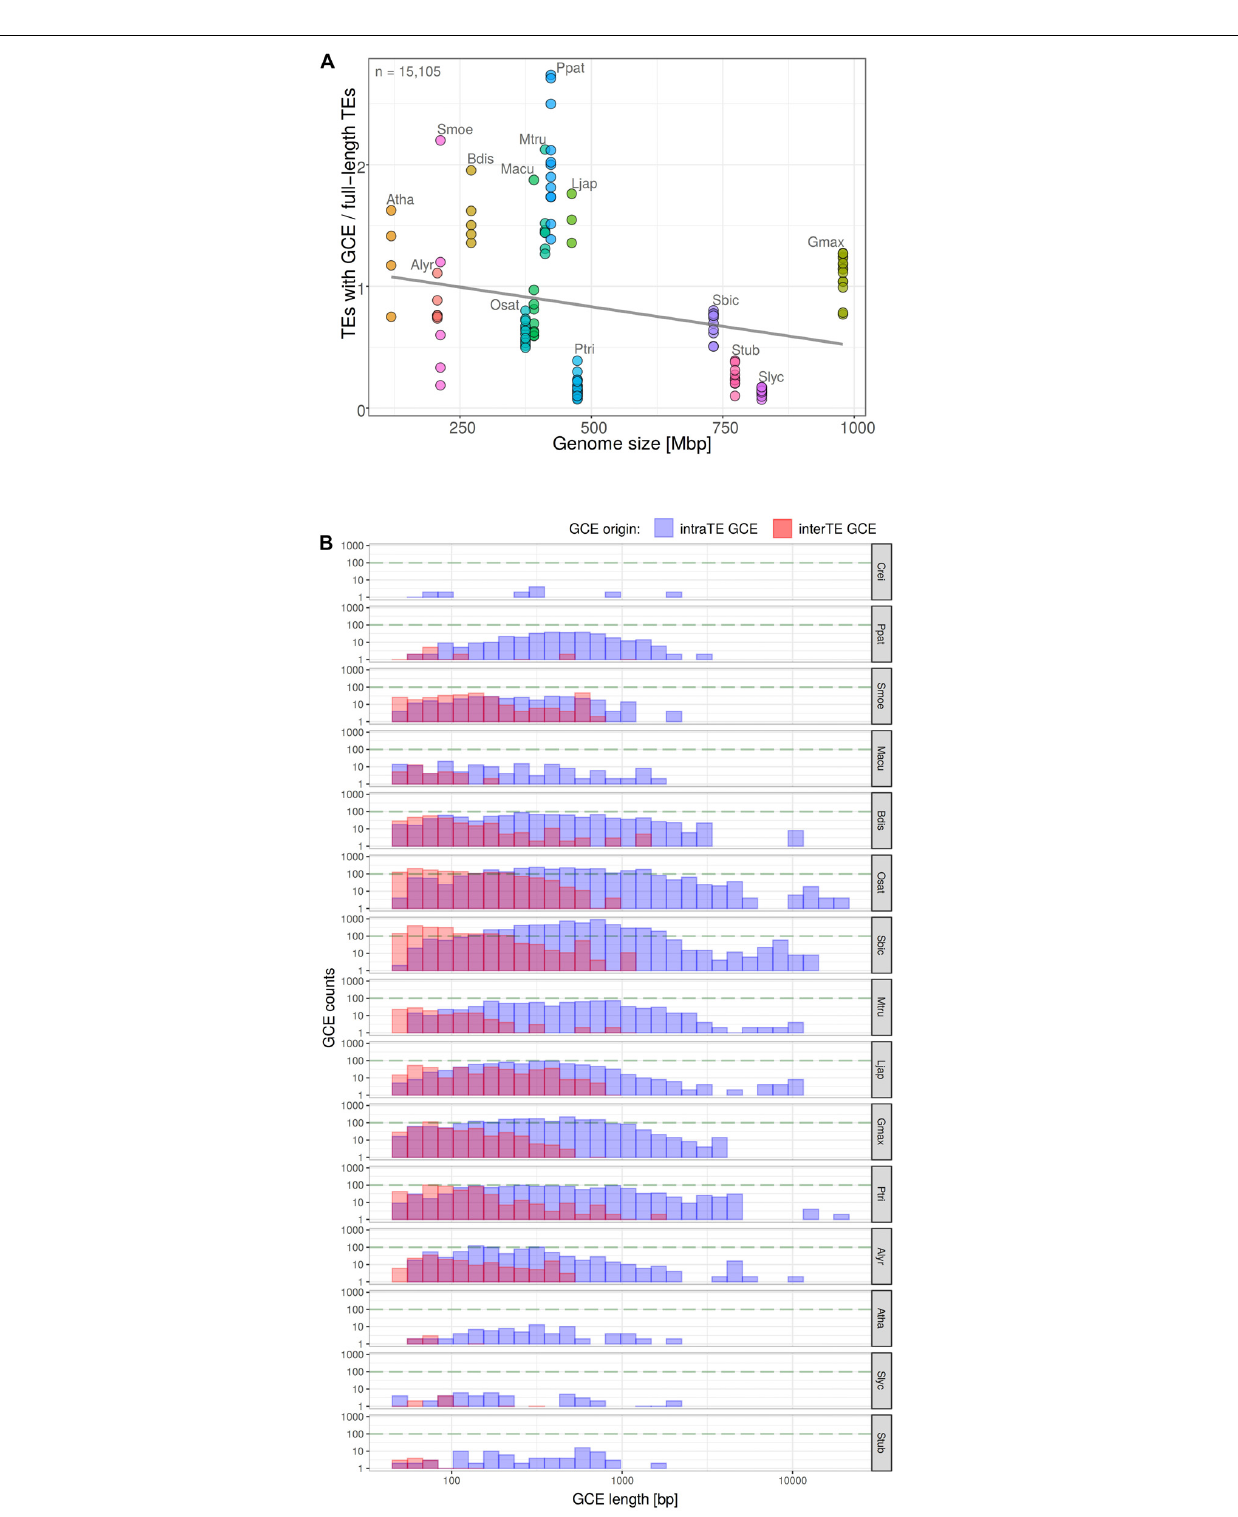
Frontiers in Plant Science |